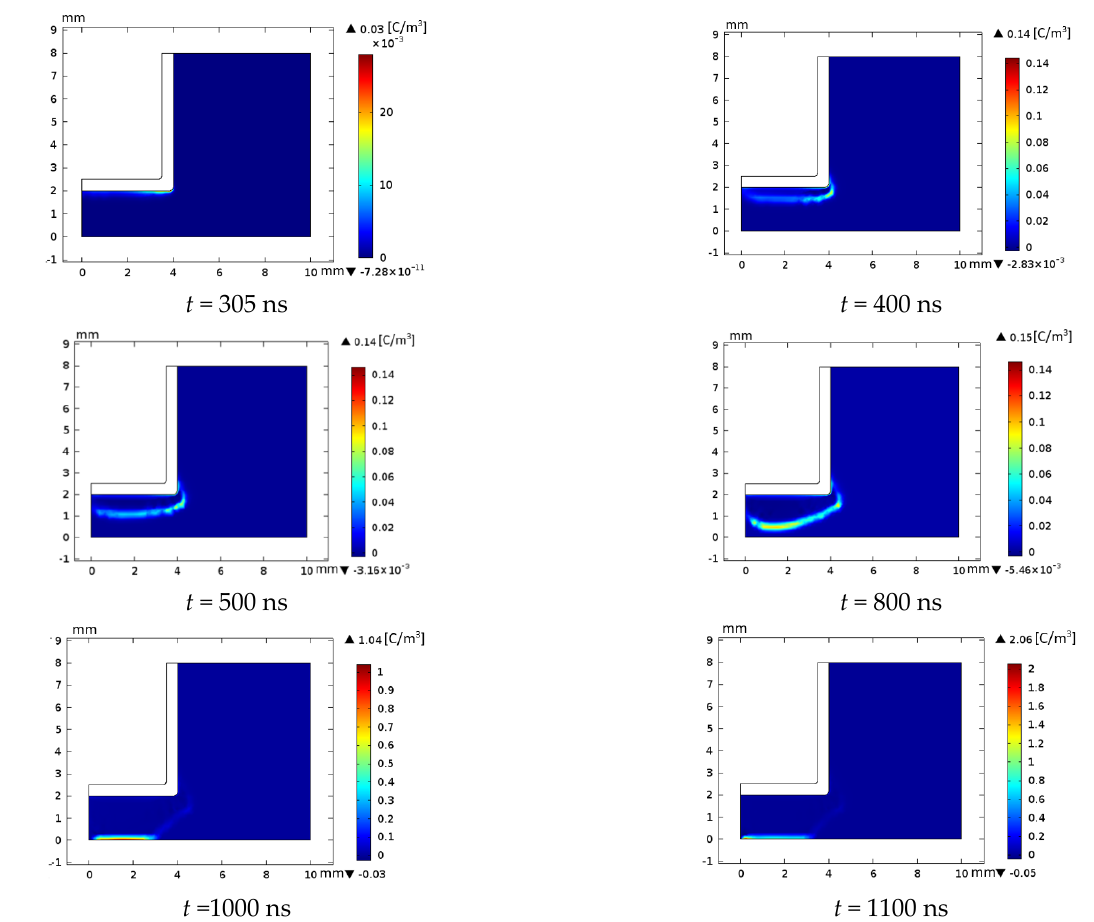
Figure 5. Space charge between the electrodes of the FE-DBD argon plasma for different instants of the rising edge of pulse discharge supplied at an applied voltage of 10 kV, a frequency of 10 kHz, and pulse duration 1 µs (t = 305 ns, 400 ns, 500 ns, 800 ns, 1000 ns, and 1100 ns).